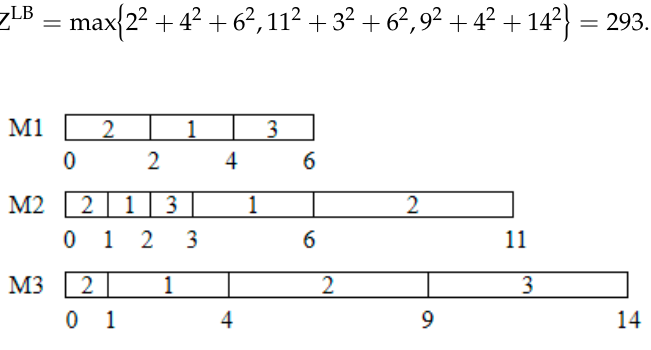
Figure 2. SRPT schedule of the lower bound.